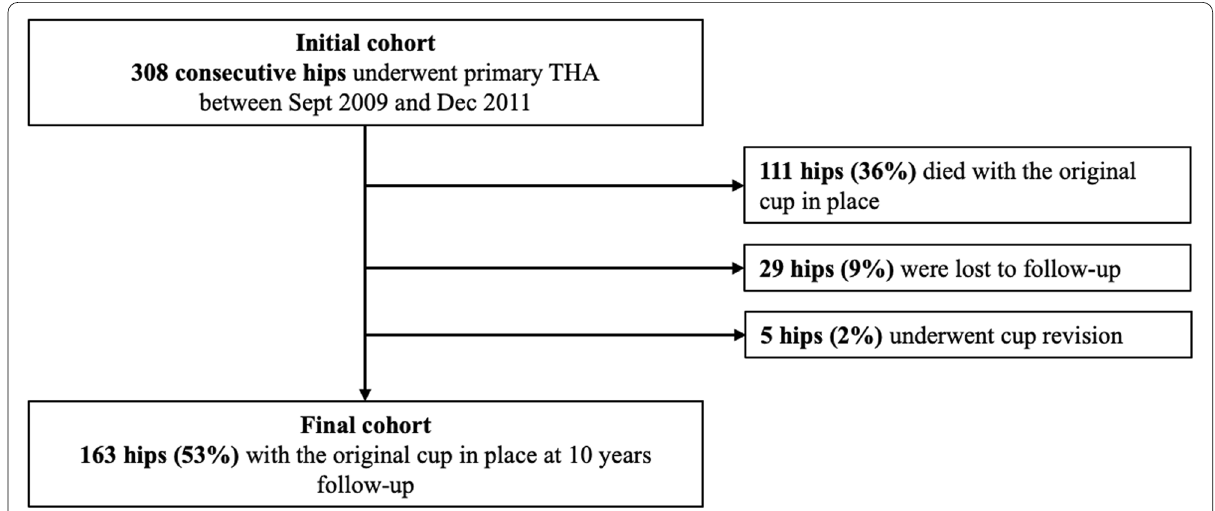
Fig. 1 Flowchart indicating that from the initial cohort of 308 patients (308 hips), 111 (36%) had died with their original cups in place, 29 (9%) were lost to follow‑up, and five (1.6%) required cup revision, thus leaving a final cohort of 163 patients (53%) with their original cup in place with a follow‑up of 10 ≥